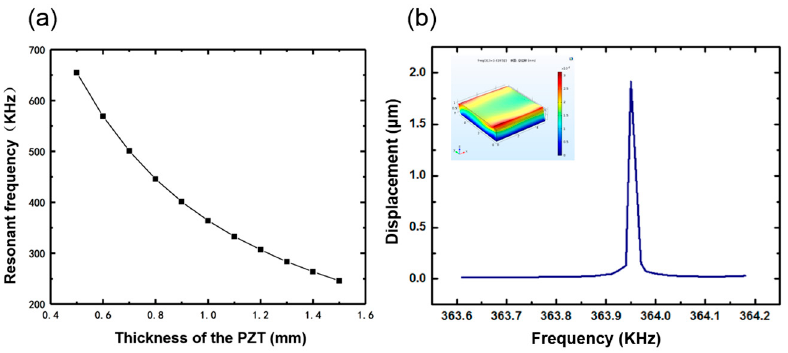
Figure 5. ( a ) Resonant frequency of the single element with di ff erent thicknesses. ( b ) The relationship between frequency and